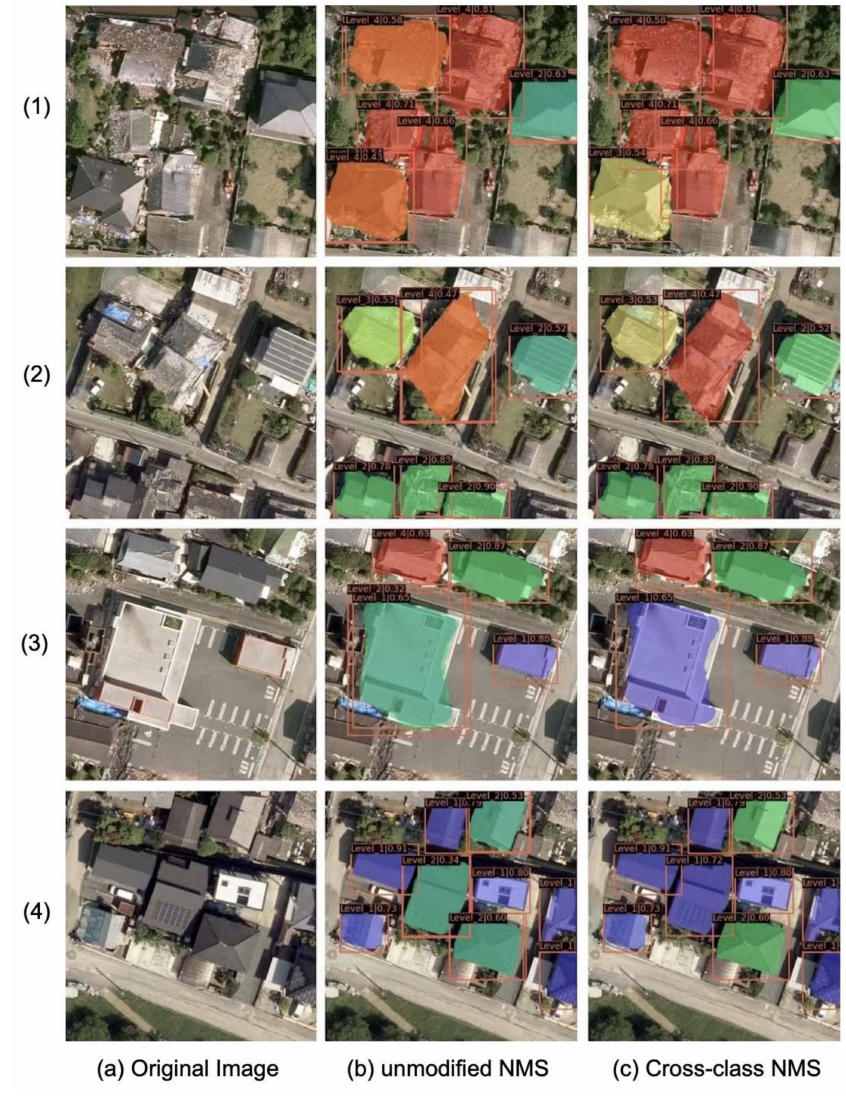
Figure 16. Comparison of the results ( a ) without the NMS, ( b ) with default NMS, and ( c ) with those after applying the multiclass NMS approach without